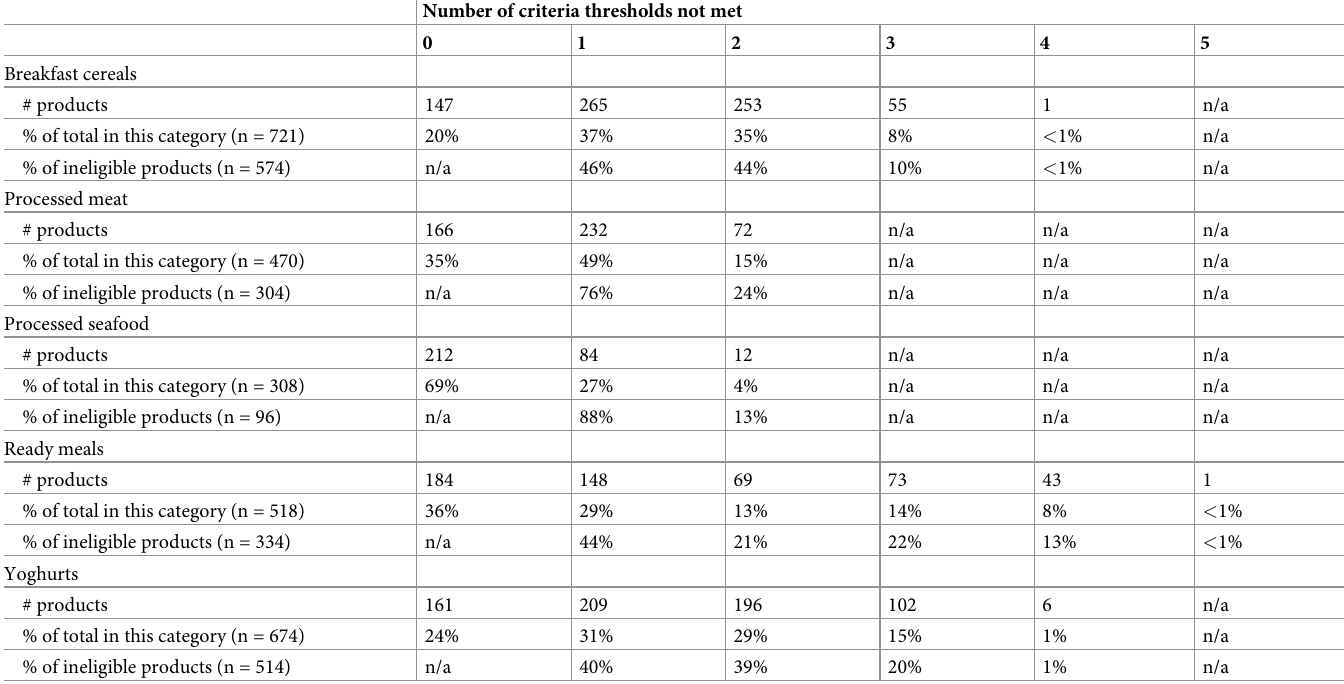
Table 4. Overview of number of products and their proportions per number of WHO Europe nutrient profile model criteria not met in each of the five product cat- egories from the Euromonitor Nutrition 2016 database. Number of criteria thresholds not